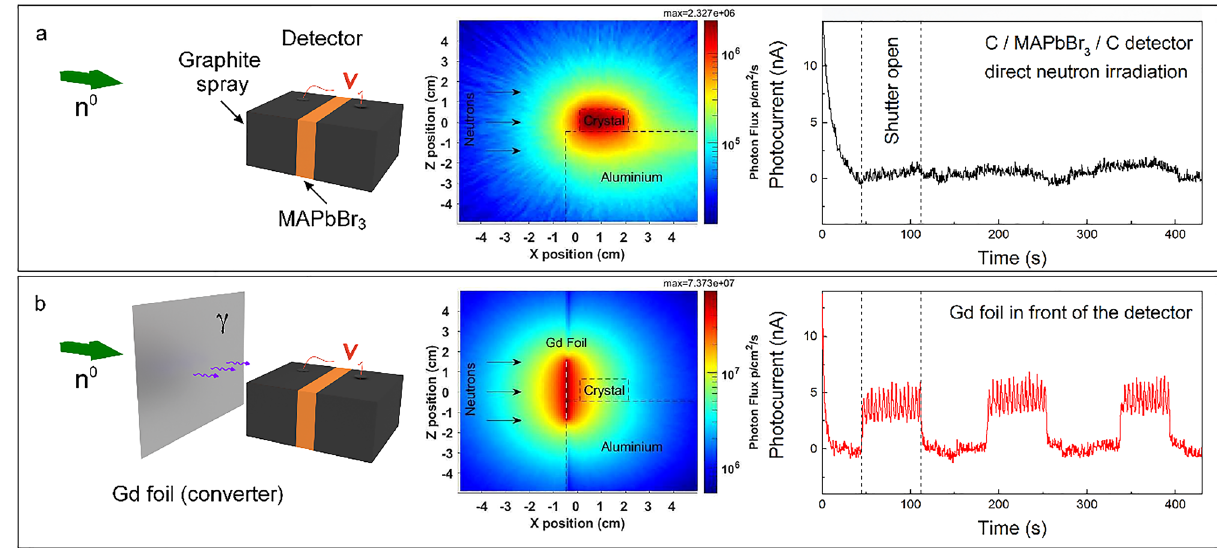
Figure 2. ( a ) Left panel: Schematic representation of the direct detection of neutron radiation by a MAPbBr 3 SC equipped with graphite spray electrodes. Neutrons are converted to secondary radiation in the MAPbBr 3 SC. Middle panel: The calculated photon flux map around the MAPbBr 3 SCs positioned on an aluminium stage. Right panel: The photocurrent acquired as a function of time. The first three periods of shutter opening are shown. ( b ) Left panel: Schematic representation of the successful detection of neutron radiation by an assembly consisting of the Gd foil and the MAPbBr 3 SC equipped with graphite spray electrodes. The Gd foil converts neutrons to detectable gamma rays. Middle panel: The calculated photon flux map around the MAPbBr 3 SCs in the presence of the Gd foil (white dashes). Right panel: The photocurrent acquired as a function of time for the first three periods of shutter opening. Measurements were performed under ambient conditions, using 1 V pulsed bias voltage (200 ms between voltage pulses). The current peaks during the open shutter stages are the result of the 10 Hz repetition rate of the neutron beam sampled with the Keithley’s readout